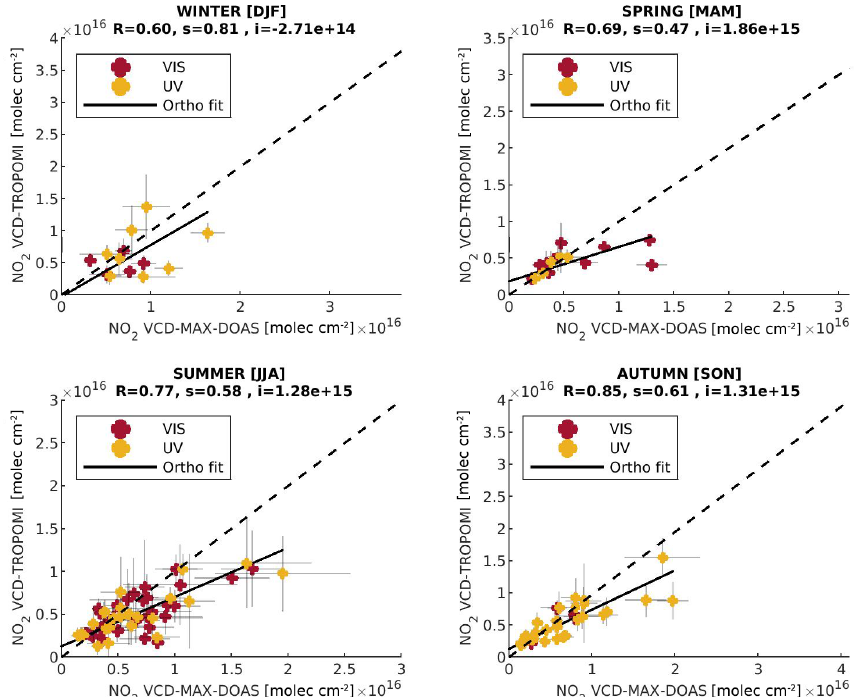
Figure 14. Seasonal scatter plots between the tropospheric NO 2 columns derived from the dual-scan MAX-DOAS observations (in the visible and UV together) and the TROPOMI pixels by using information about the MAX-DOAS horizontal effective light path and the colocation between pixels and azimuthal directions. The MAX-DOAS error bars are the same as in Fig. 11. The TROPOMI error bars represent the standard deviation of the averaged pixel values within a circle with a radius equal to the MAX-DOAS horizontal effective light